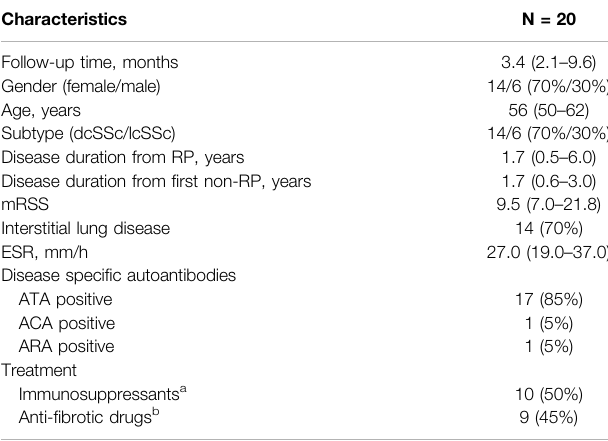
TABLE 4 | Clinical features and ongoing medications of the 20 SSc patients with longitudinal follow-ups.